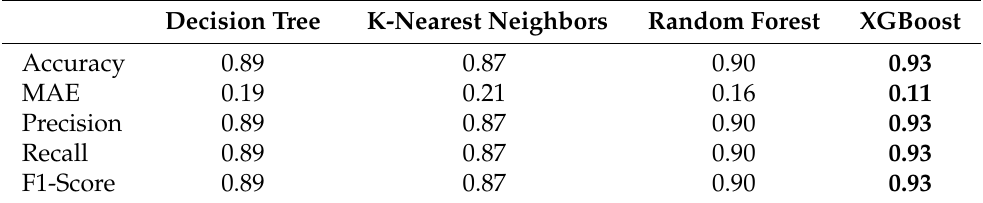
Table 2. Comparison of classifiers algorithms with expert’s segmentation. This table shows that the XGBoost algorithm is the optimal one of the four to be compared, since it presents the best accuracy, with the lowest mean absolute error.